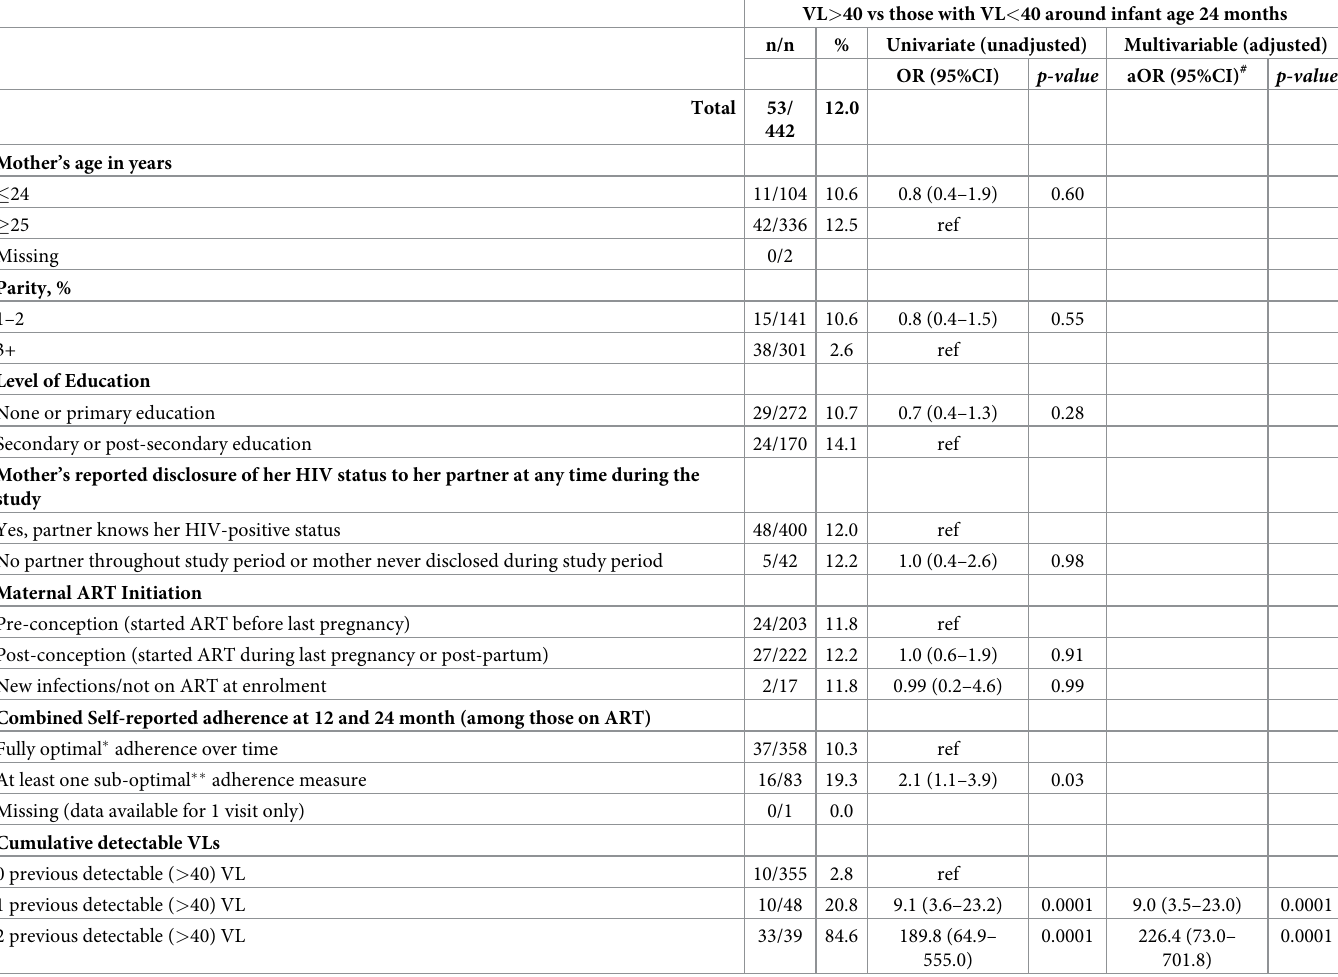
Table 4. Factors associated with detectable viral load (VL > 40) at 24 months post-partum among women on ART and having complete VL data (N =